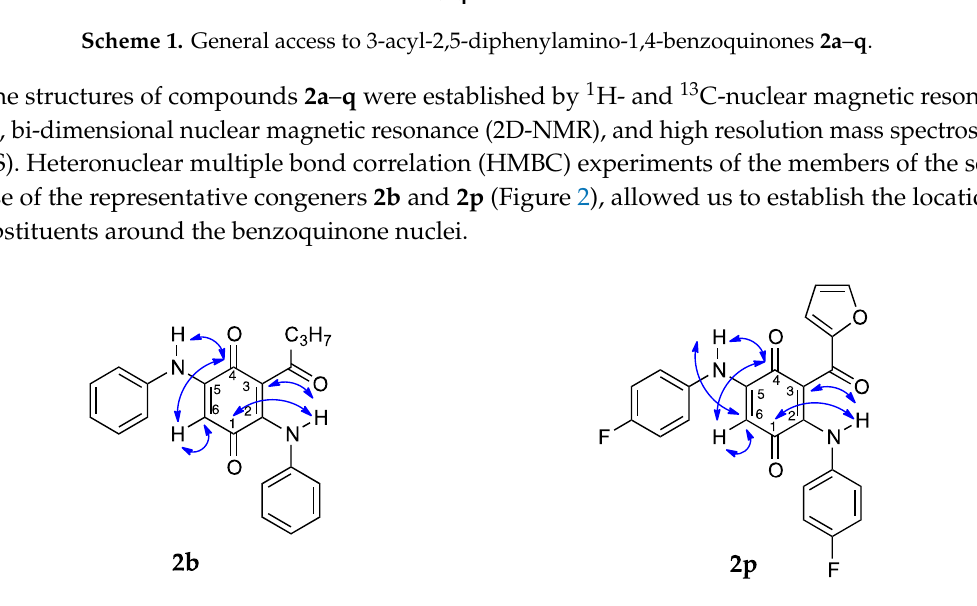
Figure 2. Heteronuclear multiple bond correlations (HMBCs) of compounds 2b and 2p.